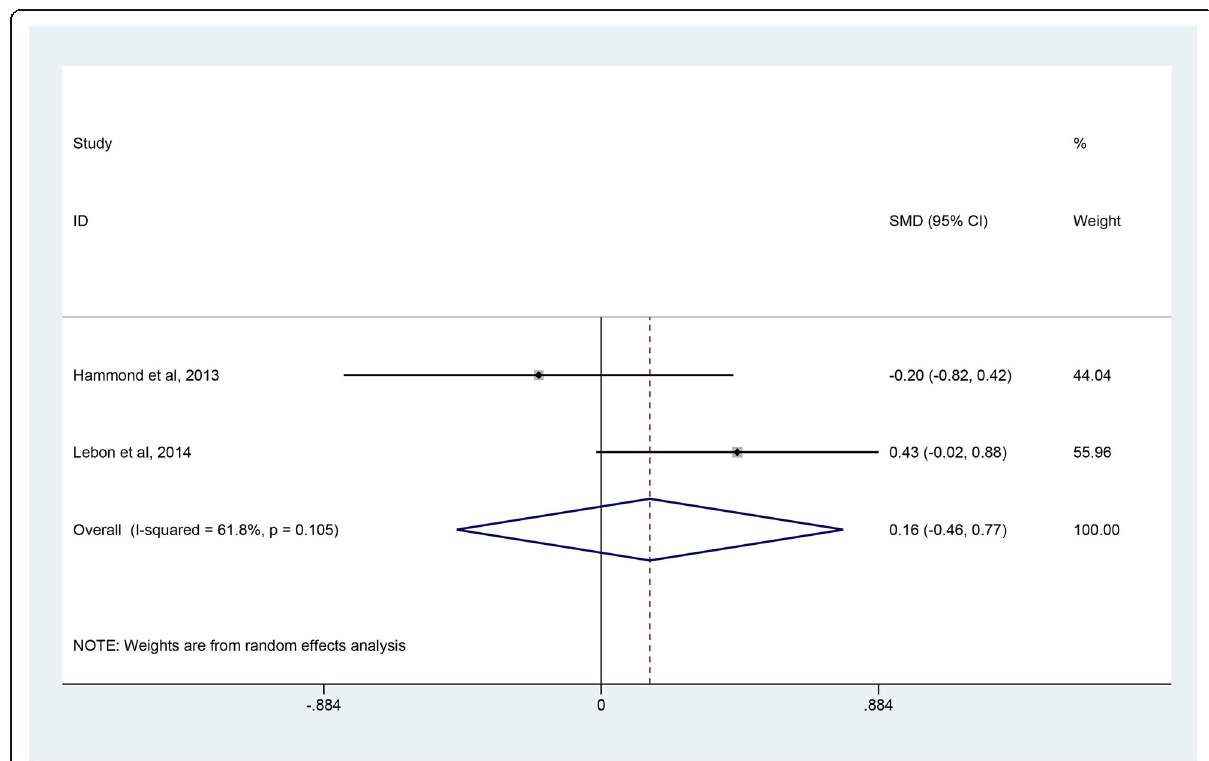
Fig. 7 Forest plot comparing the forward flexion after resurfacing hemiarthroplasty (RHA) stemmed hemiarthroplasty